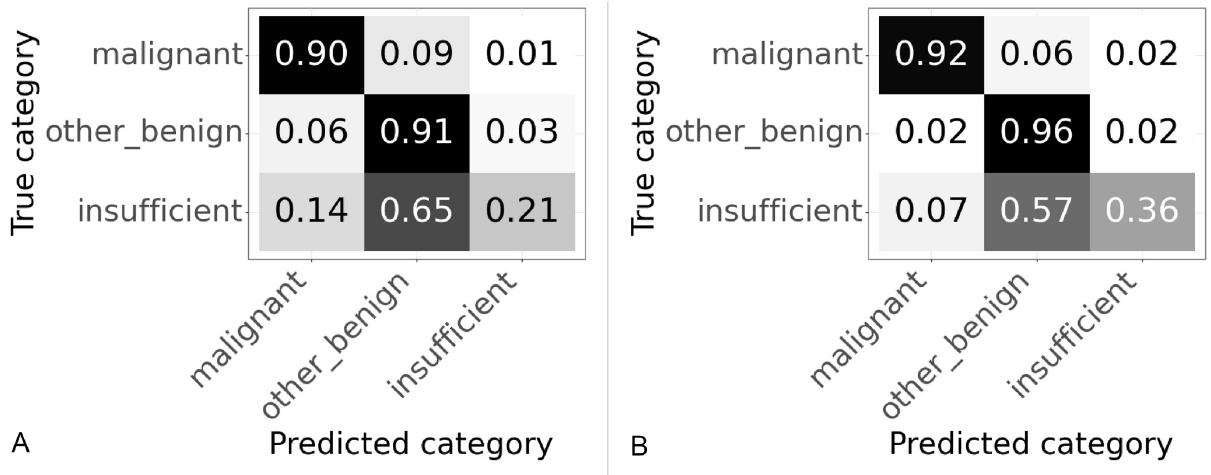
Fig 8. Confusion matrices for patches with different thresholds of tissue used to classify training patches. Results on validation set using 512 × 512. Values are normalized over the true category. (A) Any tissue in patch is a tissue patch. (B) Patch categorised according to largest category present.